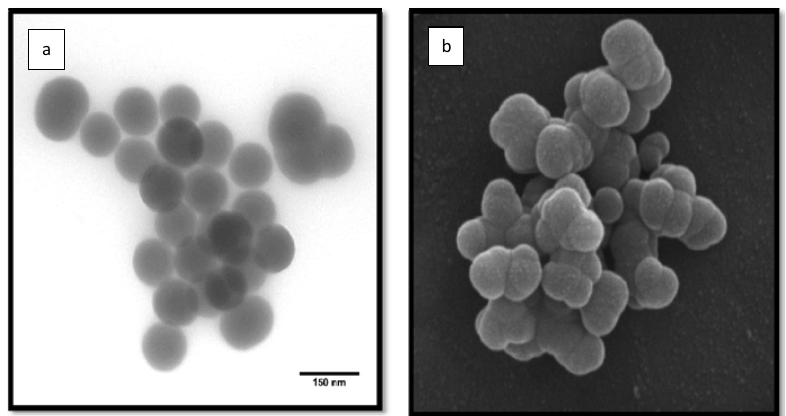
Fig. 1. The characterization of synthesized SiO 2 NPs. (a) Transmission electron microscopy (TEM); (b) Scanning Electron Microscopy (SEM)